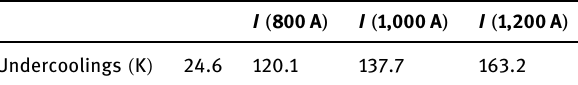
Undercoolings ( K